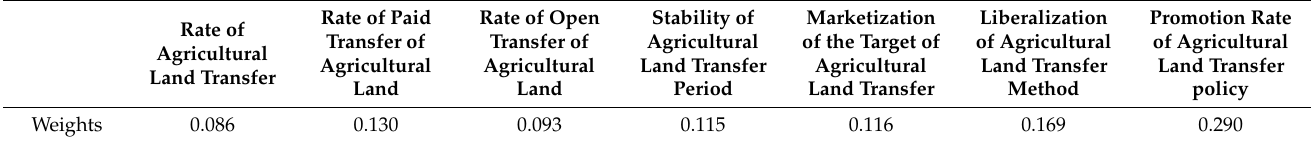
Table 4. Evaluation index weights of agricultural land transfer market.